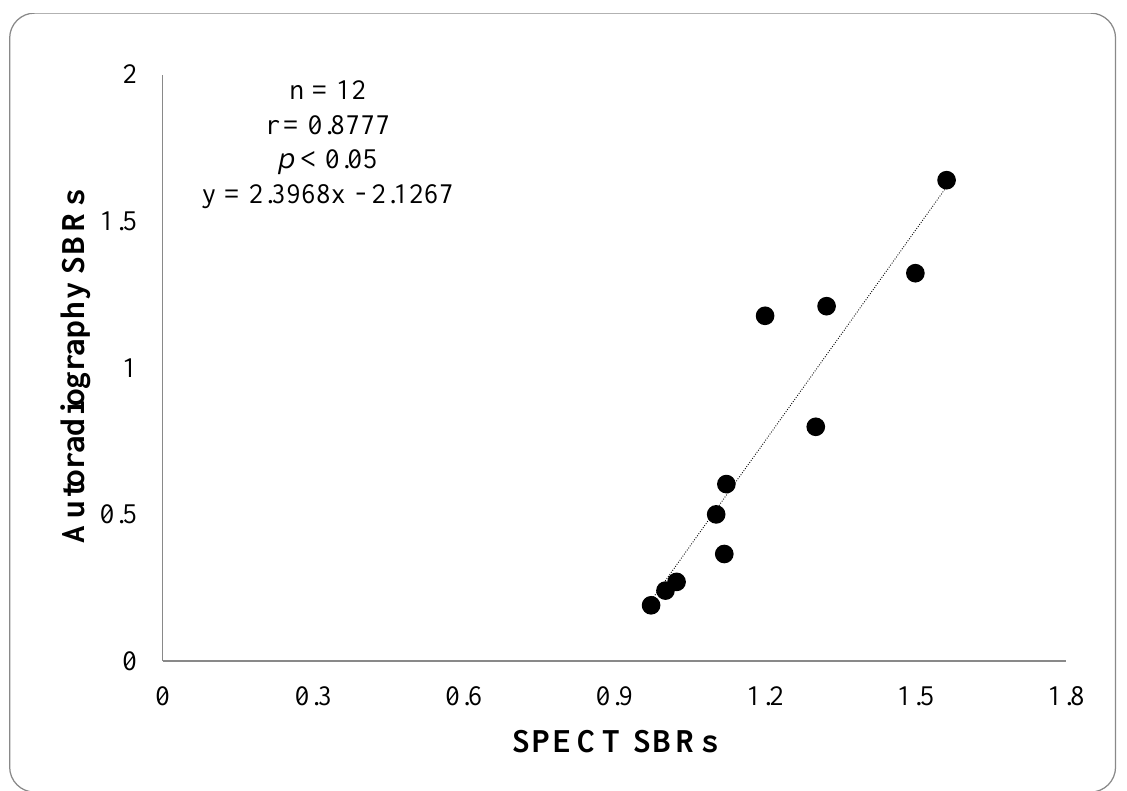
Figure 5. Correlation between specific binding uptakes (SBRs) of striatal [ 99m Tc]Tc TRODAT-1 from ex vivo autoradiography and in vivo NanoSPECT imaging (at 75 – 90min) among the three studied groups.